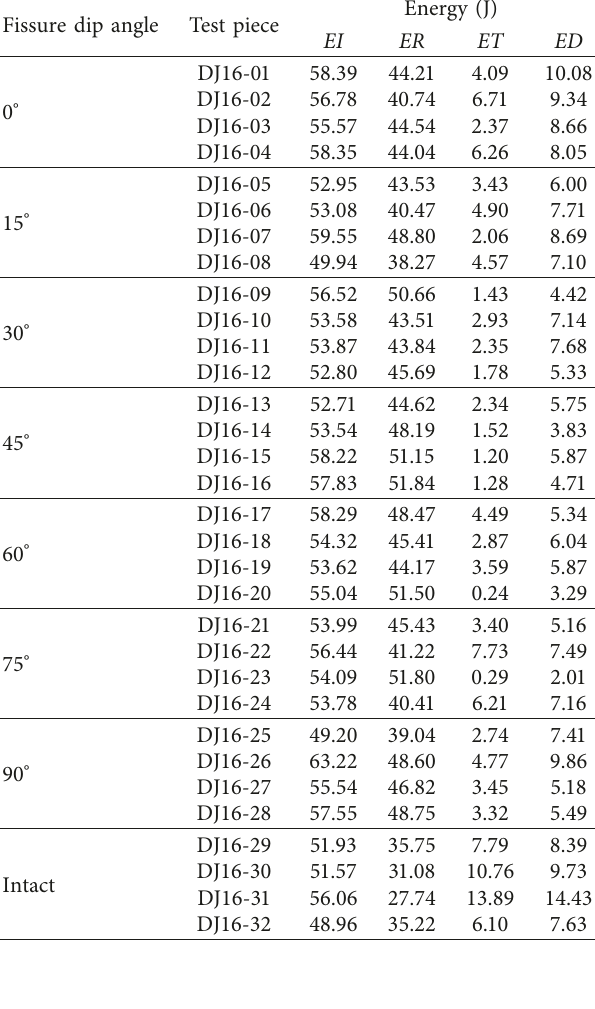
Table 2: Energy calculations of specimens with different fissure angle in each group. Fissure dip angle